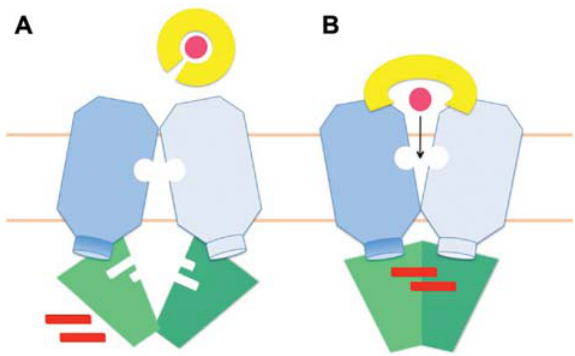
Figure 8 Schematic representation of inward-facing (A) and out- ward-facing (B) conformations of ABC importers. The color codes of the different subunits are indicated in the caption to Figure 7; the latter corresponds to an outward-facing configuration